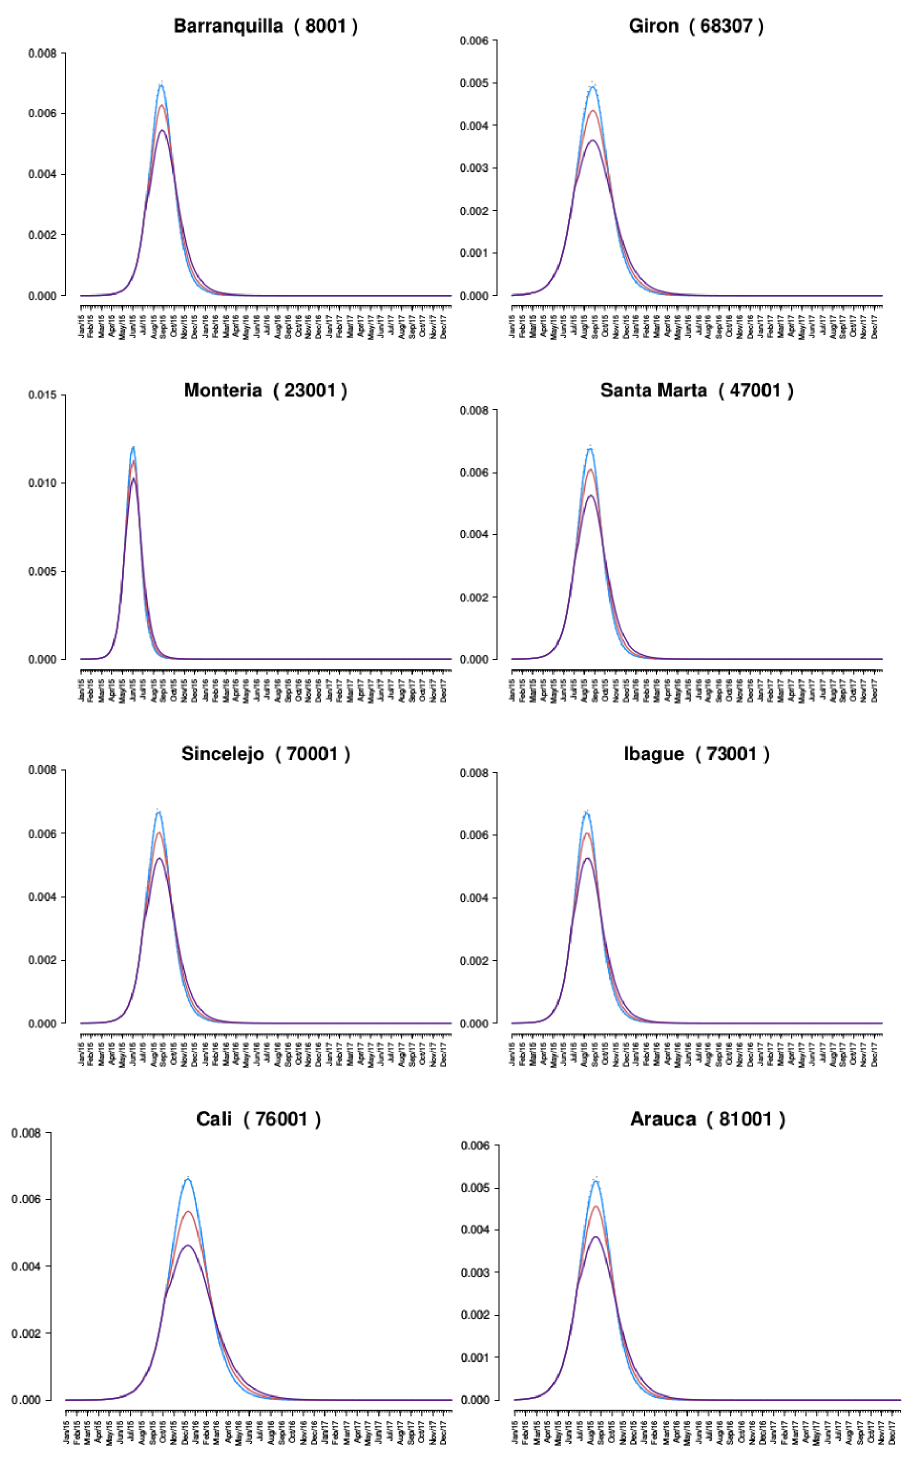
Fig 4. Comparison of the proportion of symptomatic infections of the best fit and the behavior of the epidemics when policies are implemented at th = 50%. Y-axis is a proportion (infected / at risk population), and the x-axis is time (in weeks). Best fit is dashed line, and policy 1,2, and 3 are colored blue, red, and purple, respectively.